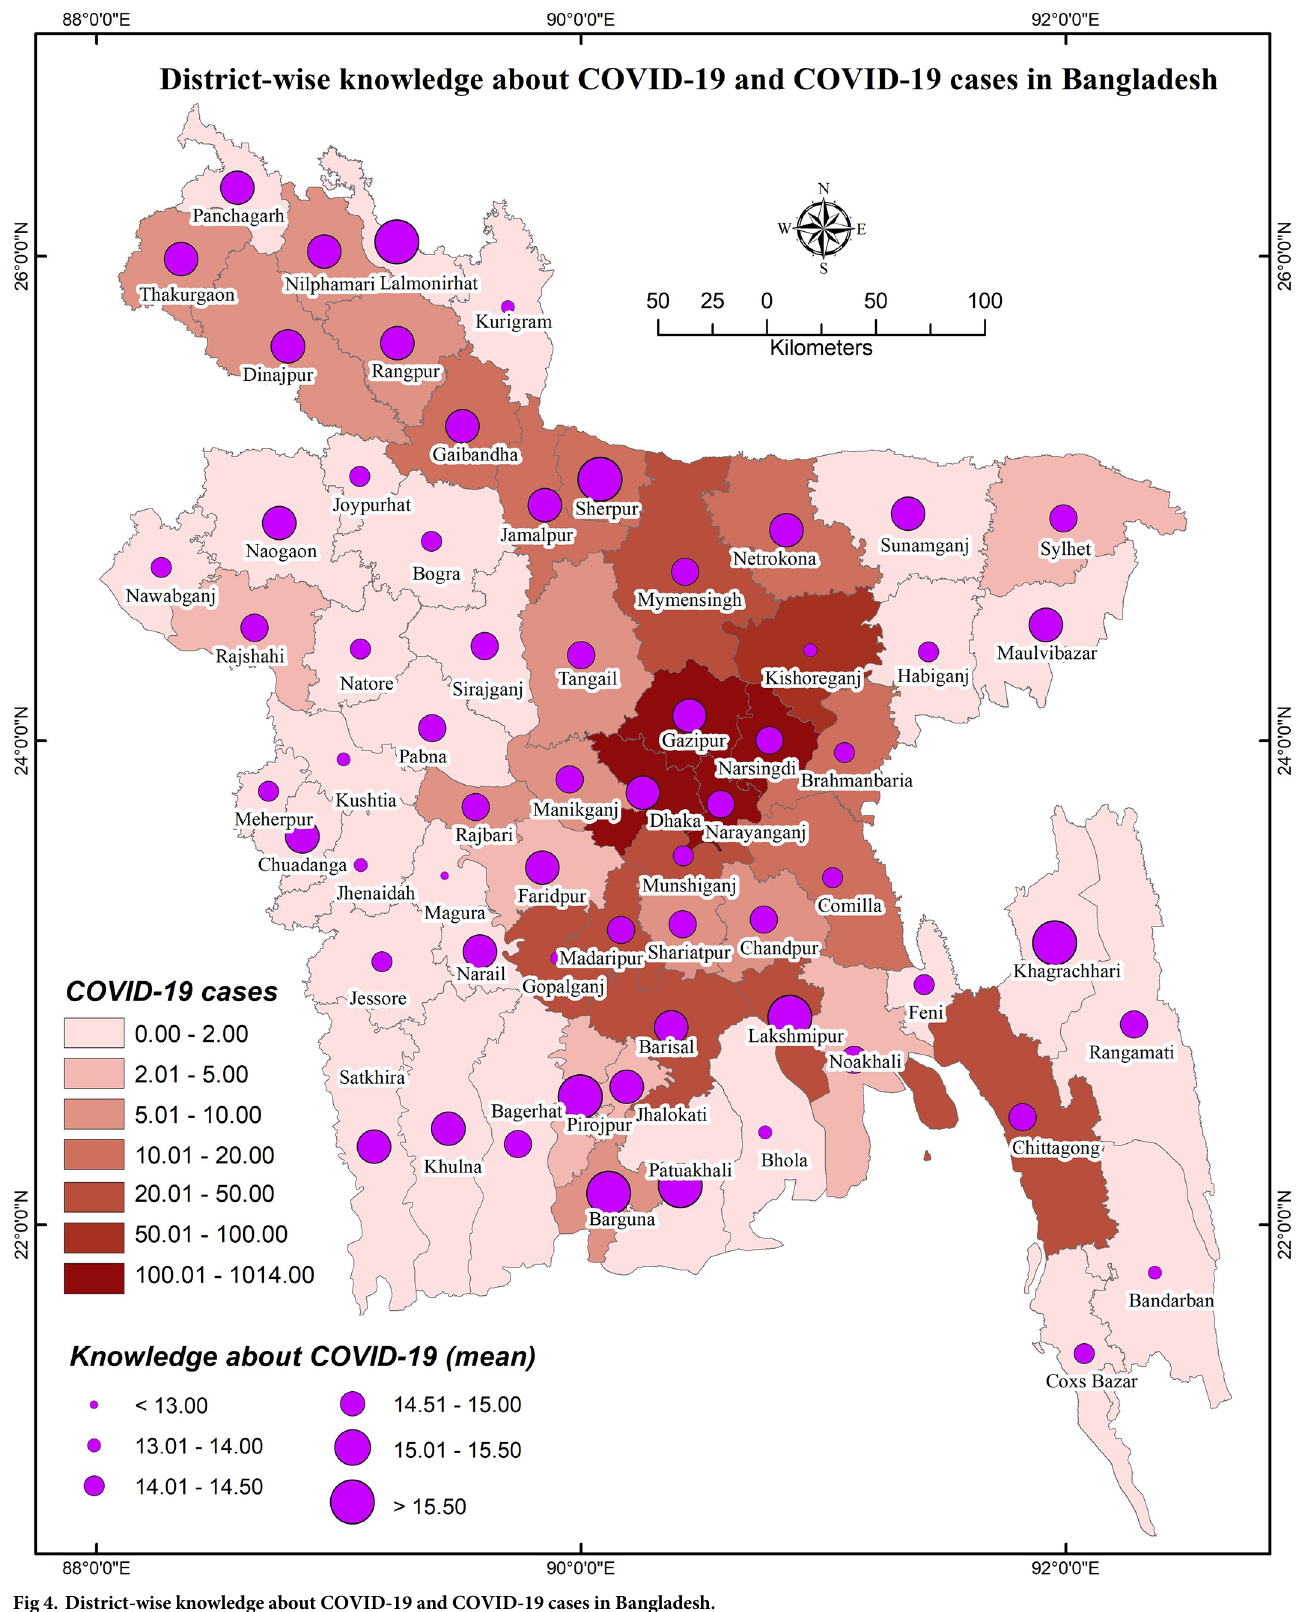
Fig 4. District-wise knowledge about COVID-19 and COVID-19 cases in Bangladesh. https://doi.org/10.1371/journal.pone.0251151.g004 PLOS ONE | https://doi.org/10.1371/journal.pone.0251151 May 3,